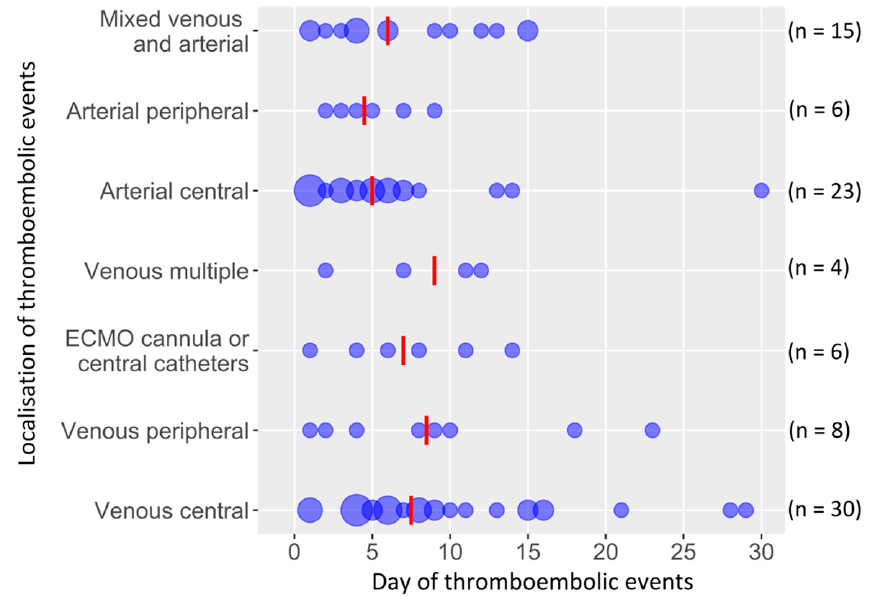
Figure 1. Locations of thrombotic events with the day of onset (circle size depends on the number of patients; red line presents the median; n = 92). Abbreviations: ECMO, extracorporeal membrane oxygenation. Arterial central (left ventricle, atrium, aortic valve and ascending aorta); venous central (right ventricle, atrium and pulmonary artery).